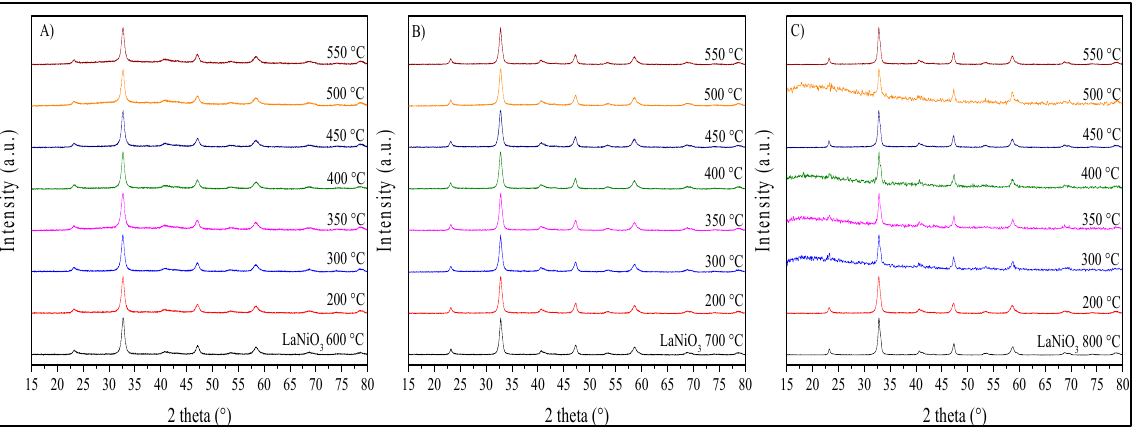
Figure 12. XRD patterns of the LaNiO 3 samples synthetized at 600 ( A ), 700 ( B ) and 800 °C ( C ) after their catalytic performance at different temperatures. The amorphization—mainly observed in some of the LNO-800 sample products—corresponds to the glass sample-holder diffraction produced due to the small quantity of sample recovered after the catalytic